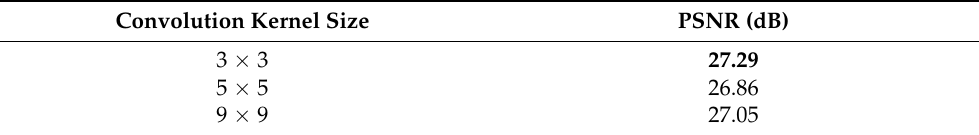
Table 2. PSNR values of DRCN with different kernels.